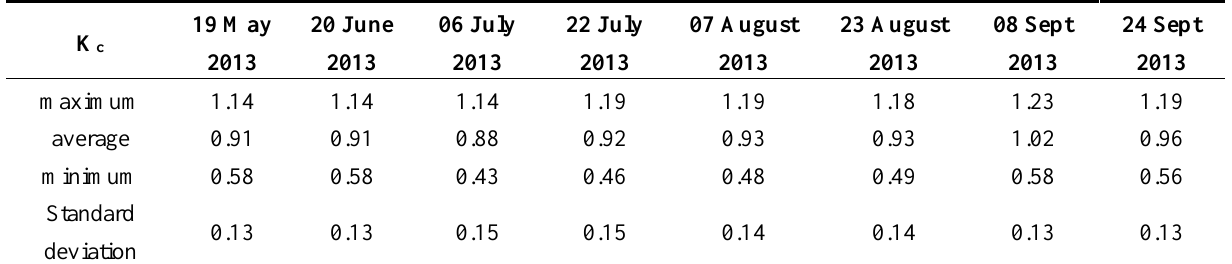
Table 3. Statistical parameters for K c values derived from Landsat 8 satellite images from the year 2013 ( n = 110 plots).